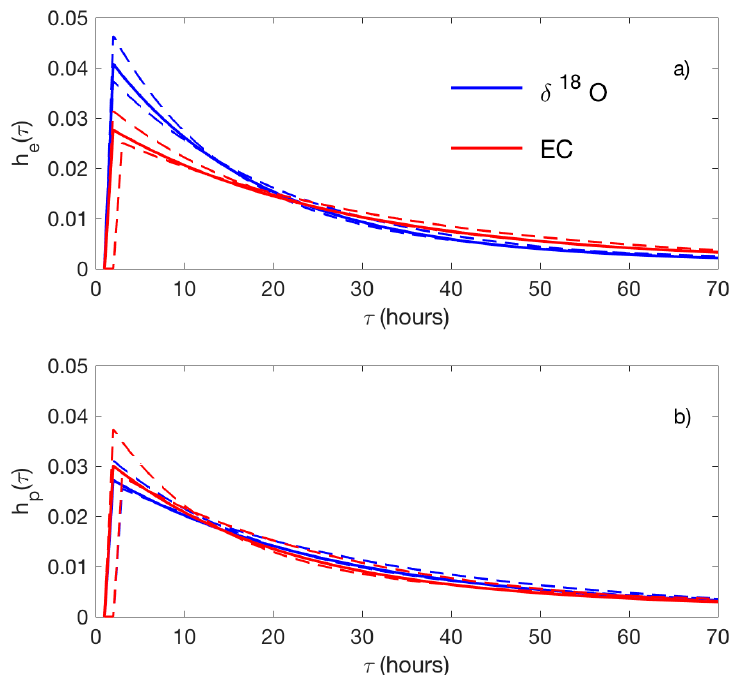
Figure 8. Transit time distributions (TTDs) of the ( a ) event (h e ) and ( b ) pre-event (h p ) flow components for model structure 4 using δ 18 O and electrical conductivity (EC) for calibration. The solid lines represent TTDs based on the 50th percentiles of behavioral (>0.75 NSE) parameter sets. The dashed lines correspond to the TTD defined based on parameter sets representing the 25th and 75th percentiles of their distributions.